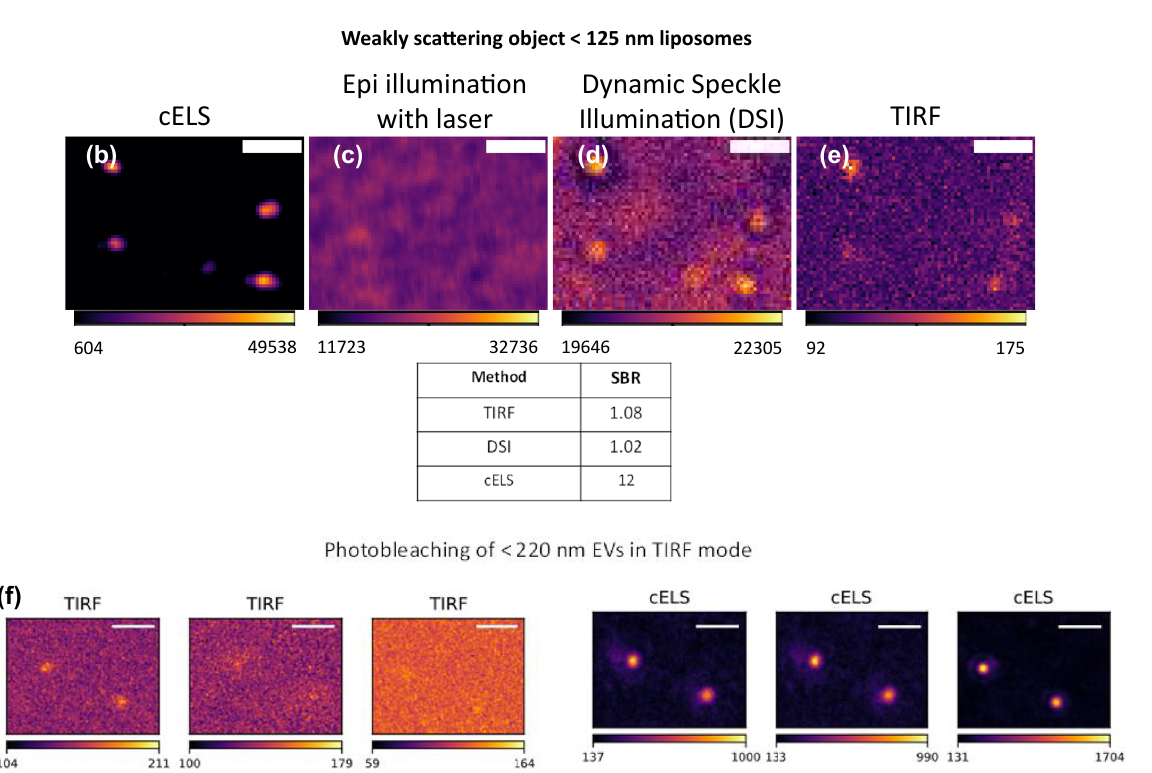
Figure 3: Experimental results of weakly scattering specimens. (a) cELS and TIRF images of 60 nm polystyrene beads. The signal to background ratio (SBR) is given in the table and the Fourier transform of the beads imaged using cELS and TIRF is given alongside. Scale bar 2 μ m in the image plane ( x – y plane) and 5 μ m − 1 in the spatial frequency plane ( 𝛼 – ß plane). The colorbar shows the intensity variation along the dotted lines in the Fourier plane. (b) Liposomes of < 125 nm in size imaged using epi-illumination laser mode, (c) TIRF mode, (d) Dynamic Speckle Illumination mode and (e) cELS are compared. The colorbar shows the pixel values of the images. The corresponding SBR is given in the table below. Scale bar 2 μ m. (f) cELS and TIRF images of < 225 nm sized extracellular vesicles (EVs). The TIRF image shows photo-bleaching with time whereas cELS allows long-term imaging of the EVs. A larger field-of-view image of EVs is provided in Supplementary article, Figure S7. The colorbar shows the pixel values of the images. Scale bar 2 μ